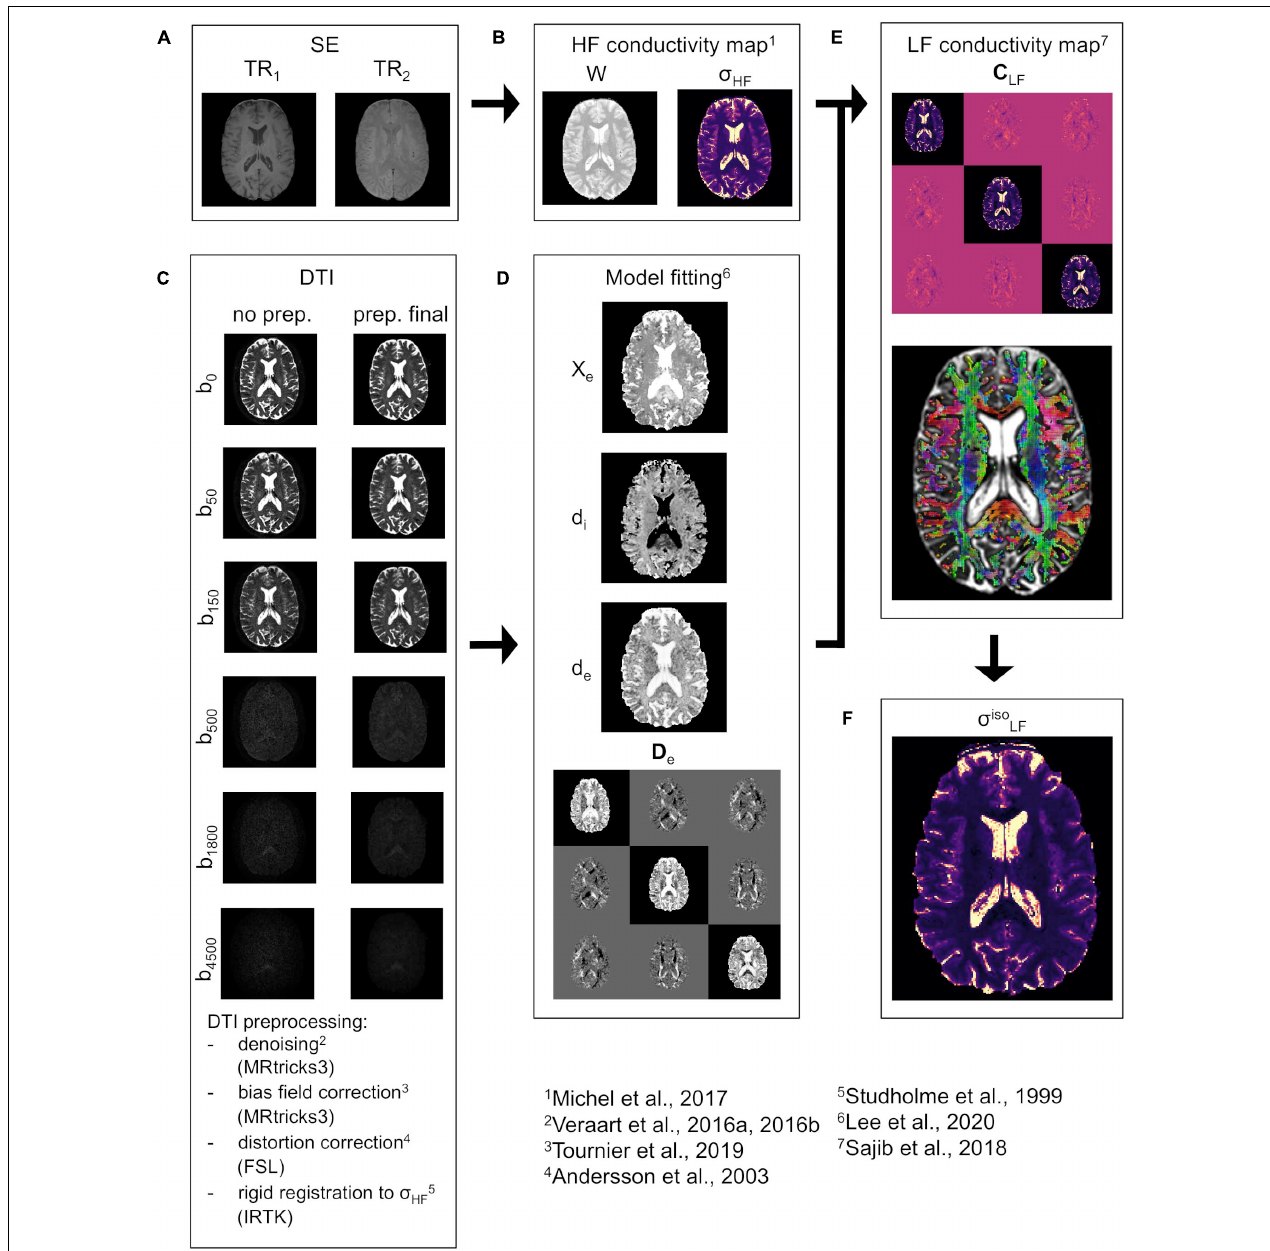
FIGURE 1 | CTI reconstruction framework. (A) SE data acquired at TR 1 and TR 2 . (B) Water map W and isotropic conductivity σ HF map. (C) DTI data before (left) and after (right) pre-processing at all b-values (vertical direction, diffusion encoding direction chosen at random). (D) Estimated extracellular volume fraction χ e , intra and extracellular water diffusivities d i and d e , and extracellular water diffusion tensor D e . (E) LF conductivity tensor C LF (top) together with the orientation distribution function (ODF) representation (bottom) in WM and GM. (F) “isotropic equivalent” LF conductivity map σ iso LF